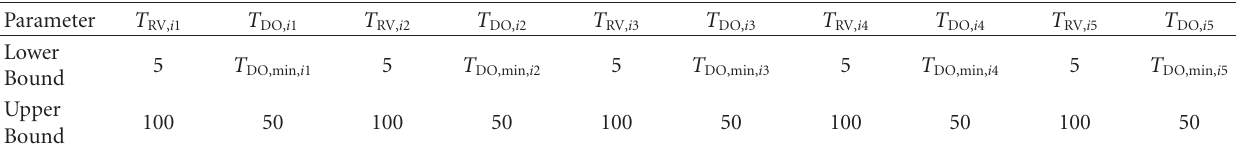
Table 5: Optimisation